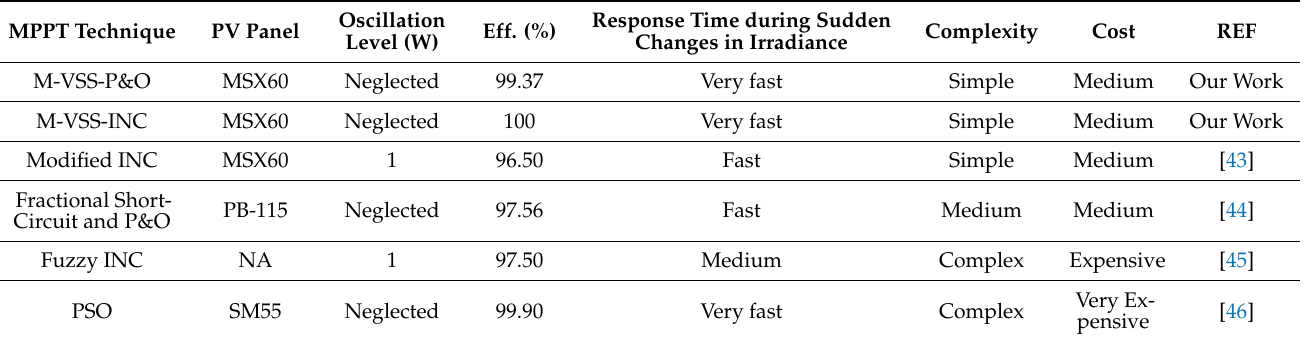
Table 4. Comparison of the proposed algorithms with other algorithms proposed in the literature.